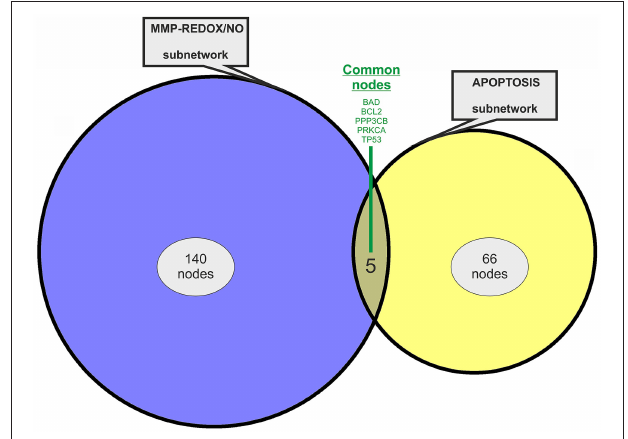
FIGURE 2 | Venn diagram showing information integration from the studied subnetworks. The “MRN” (MMP-REDOX/NO) and “APOP” (apoptosis) network models contain five common nodes